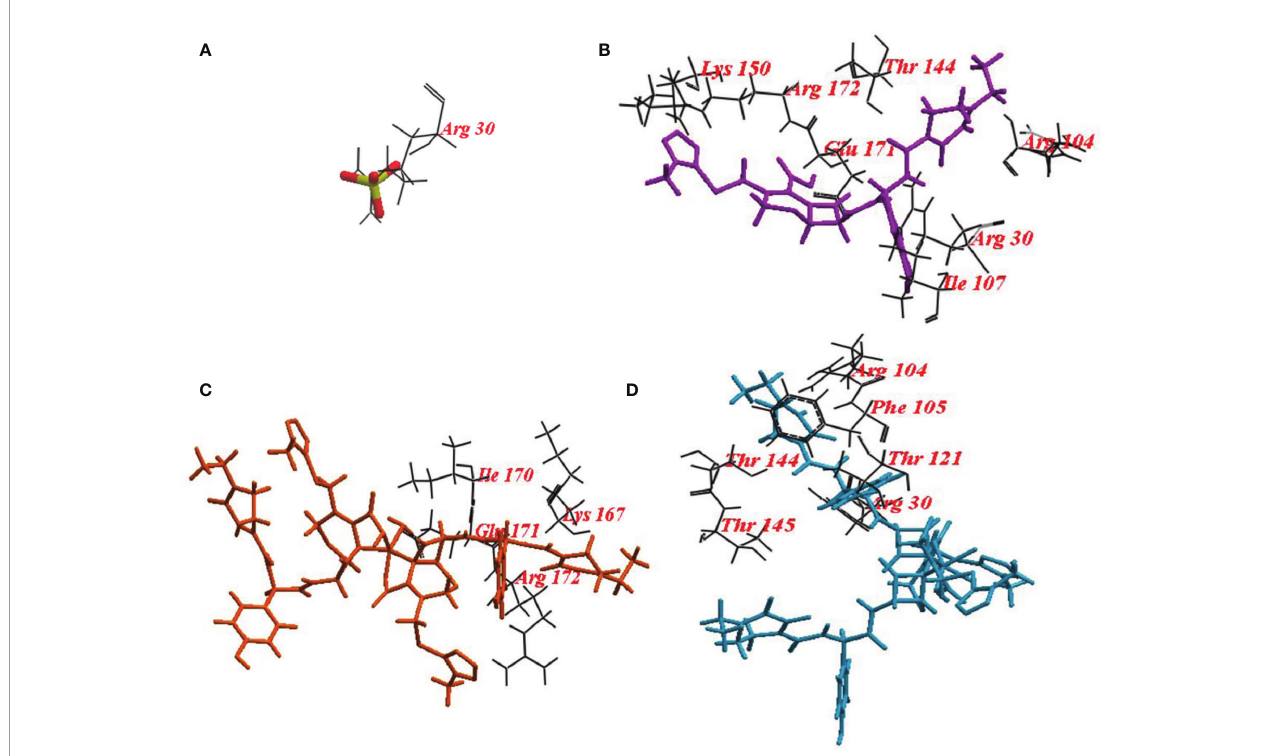
FIGURE 6 | Binding mode of (A) redocked sulphate ligand; (B) Cefoperazone (CFP); (C) , Cefoperazone-Cobalt complex (CFPC) and (D) Cefoperazone-Iron complex (CFPF) into the Crystal structure P. aeruginosa acyl-homoserinelactone synthase